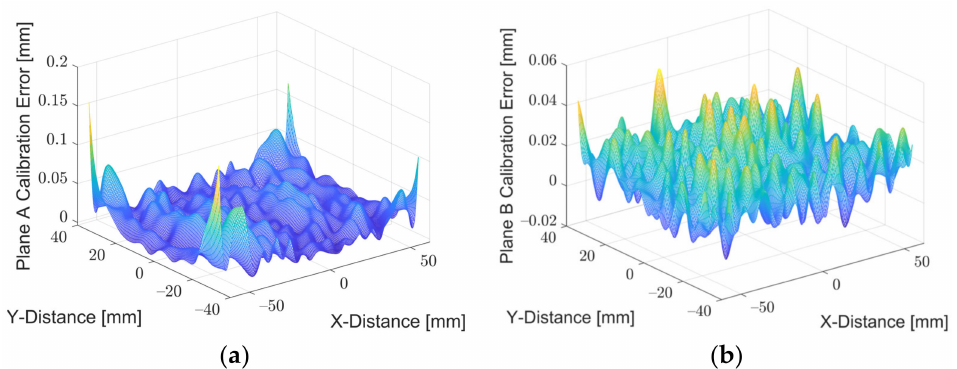
Figure 8. Error contours of each calibration plane: ( a ) Plane A; ( b ) Plane B.